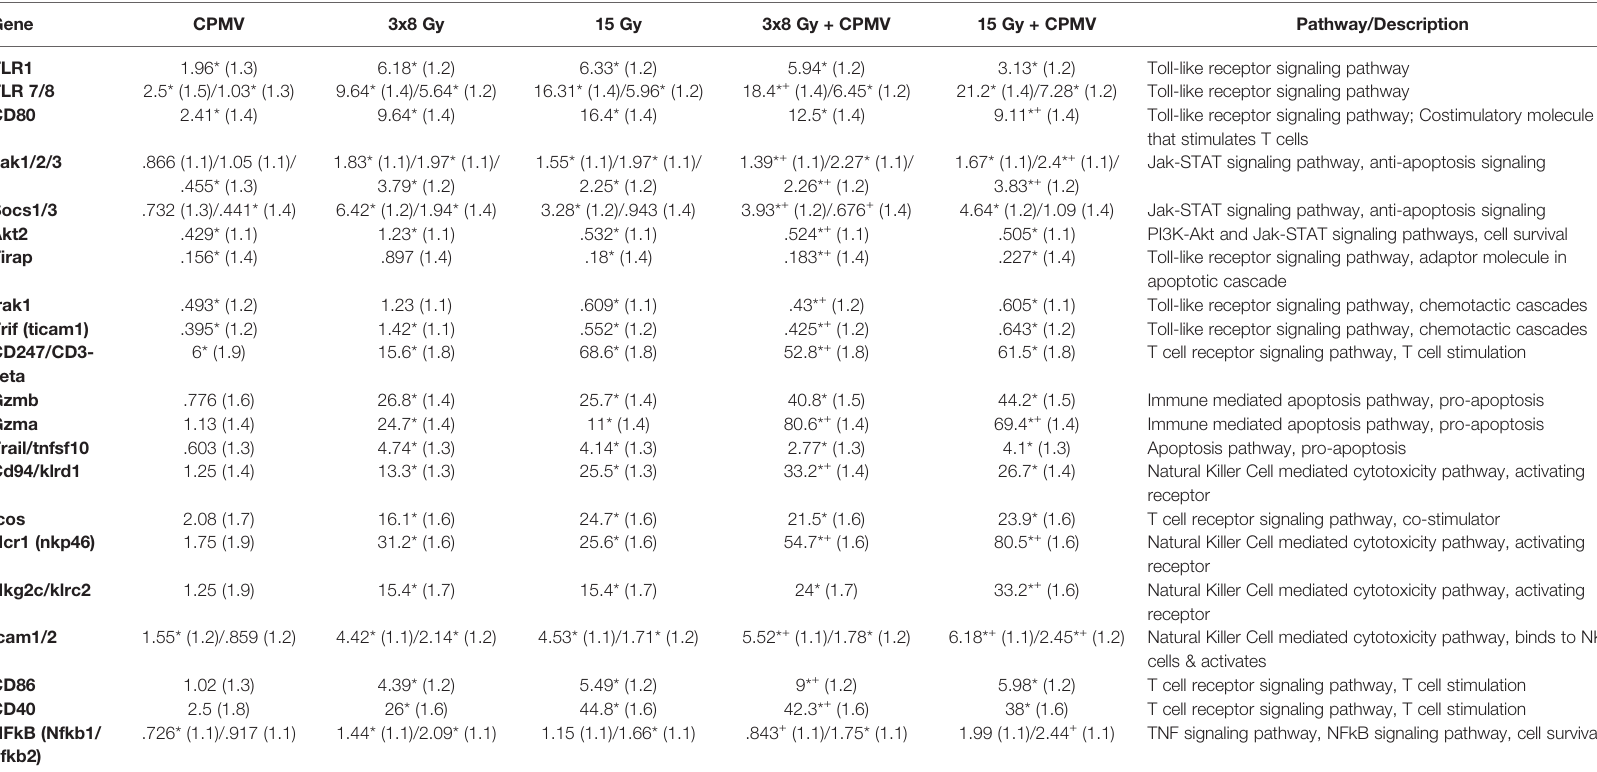
ChangesinmRNAarereportedforalltreatmentgroups,withtheirimportancedemonstratedbythepathway/descriptionandalsodescribedinthetext.*indicatesadjustedBYp<.05,ascomparedtocontrol. + indicatesadjustedBYp<.05,as compared to the radiation alone (3x8 Gy or 15 Gy,